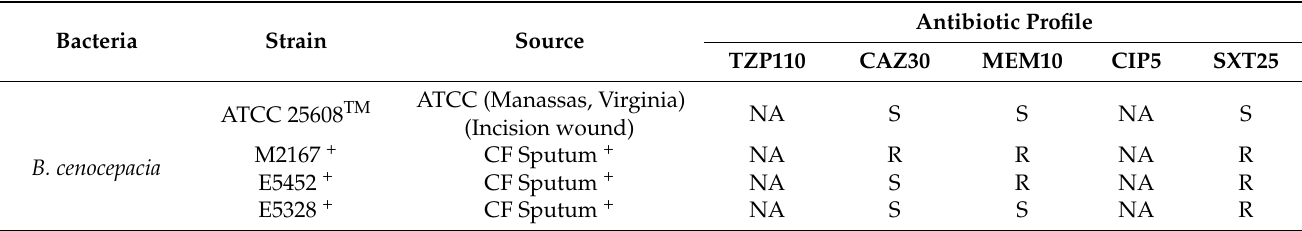
Table 1. Source and antibiotic profiles of bacterial species